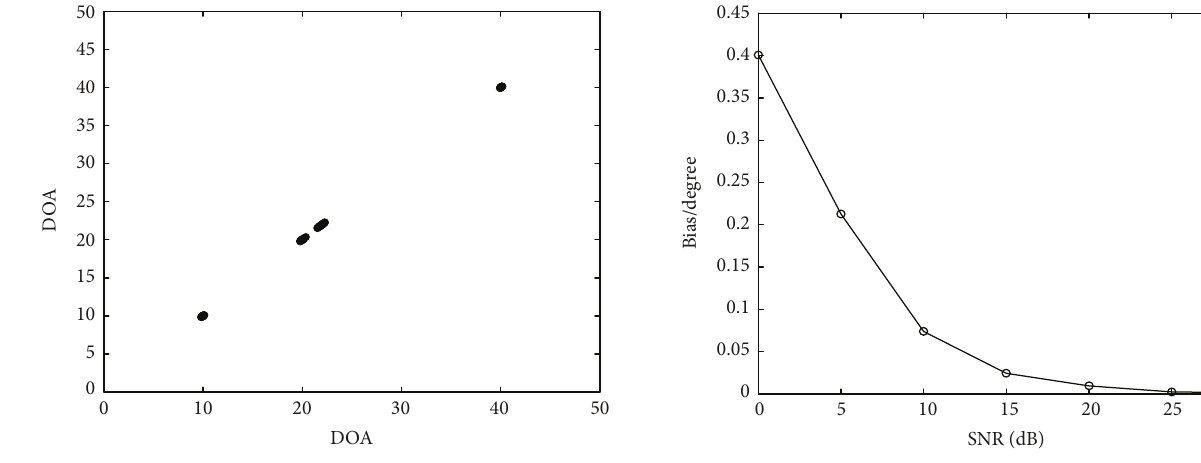
independent trials, SNR = 15dB .